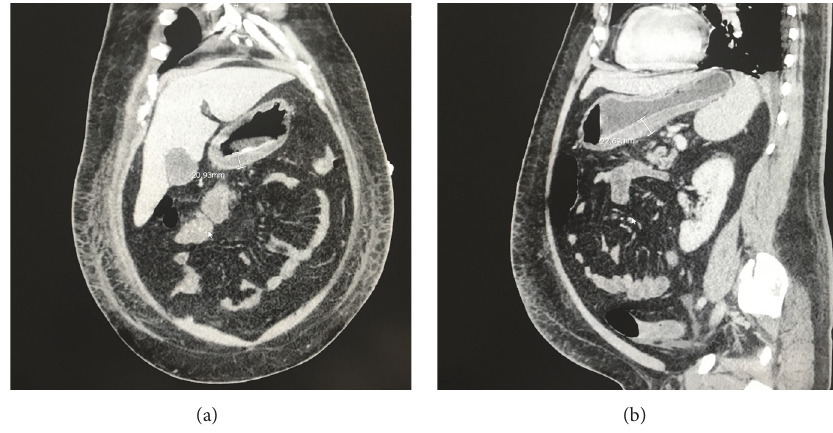
Figure 1: Thickening of the gastric submucosa on coronal (a) and sagittal (b)